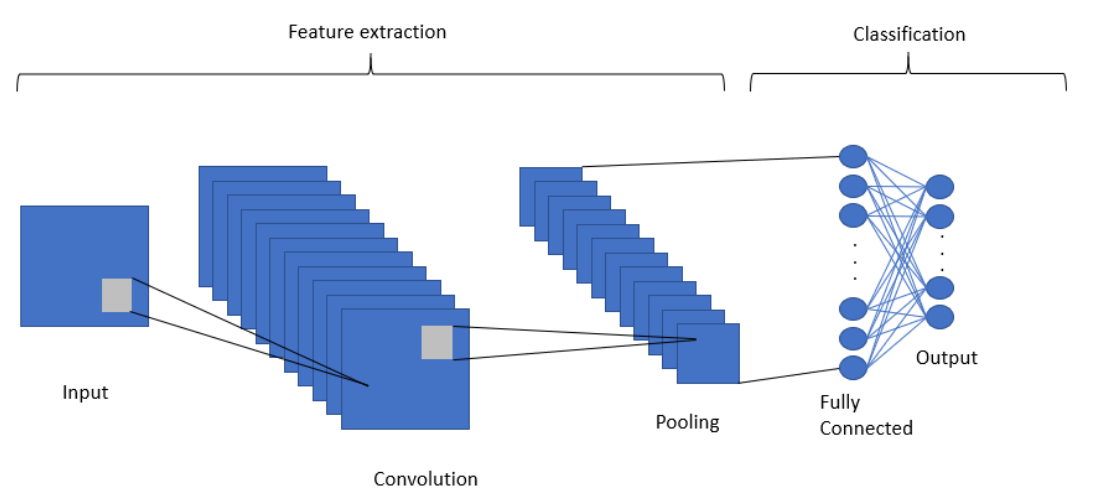
Figure 8. Deep convolutional neural network operation.